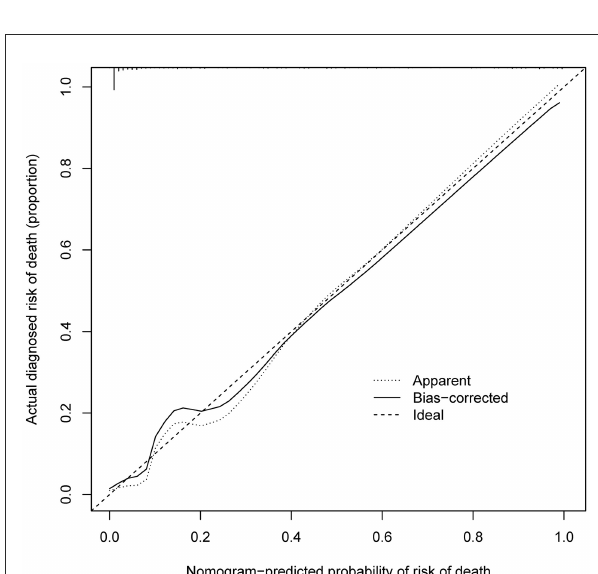
FIGURE5 Calibration curves of in-hospital death nomogram predicting in the cohort. B = 1,000 repetitions; boot Mean absolute error = 0.016; Mean squared error = 0.0004. Calibration curve represents probability of patients with AD. The X-axis is the predicted probability by nomogram and the y-axis represents the actual diagnosed risk of in-hospital death. The diagonal dotted line represents a perfect prediction by an ideal model. The black solid line shows the performance of the nomogram, of which a closer fit to the dotted line means a better prediction.